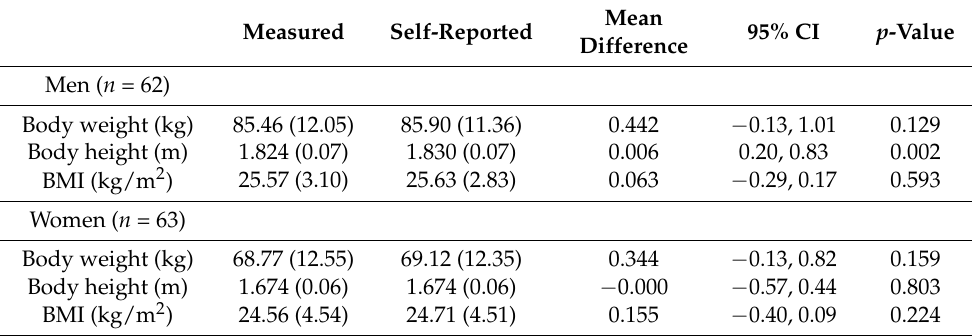
Table 2. Comparison between measured and self-reported body weight, height, and BMI * (kg/m 2 ) by gender. Results are presented as mean and (standard deviation, SD), mean difference, 95% Confidence Interval (CI) and p -value.